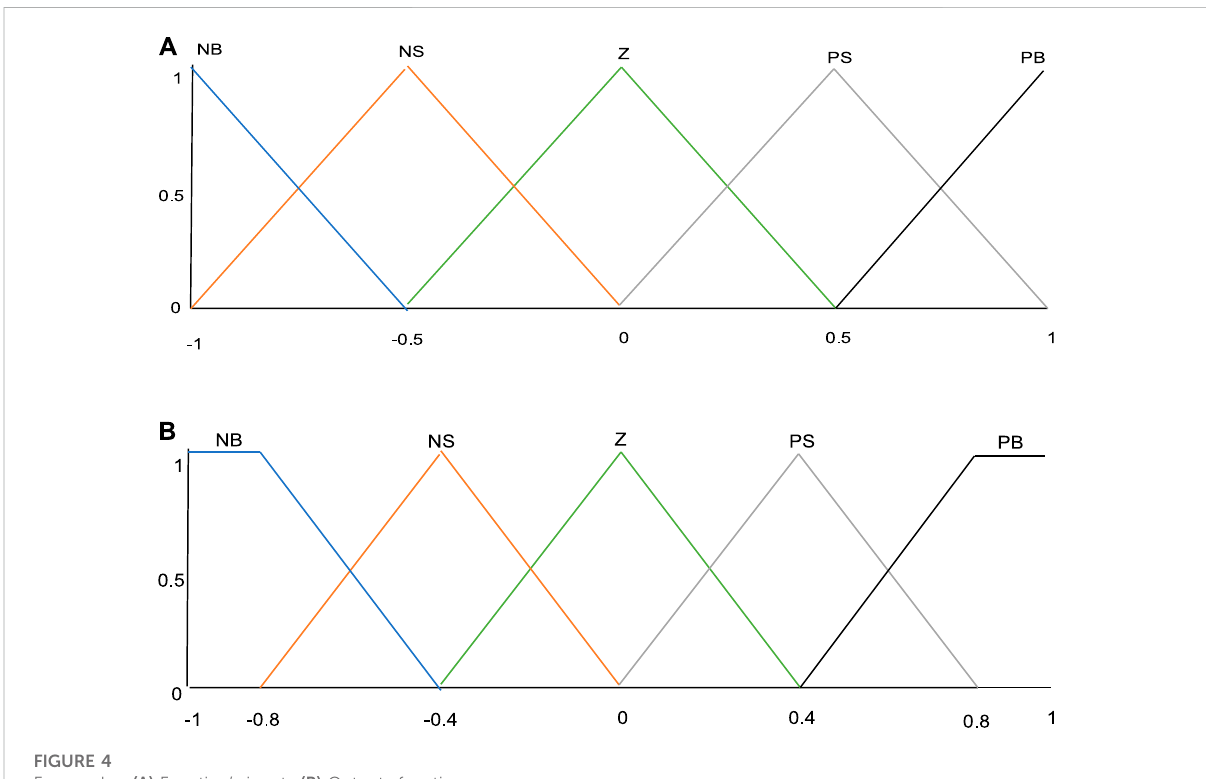
FIGURE 4 Fuzzy rules. (A) Function ’ s inputs (B) Outputs